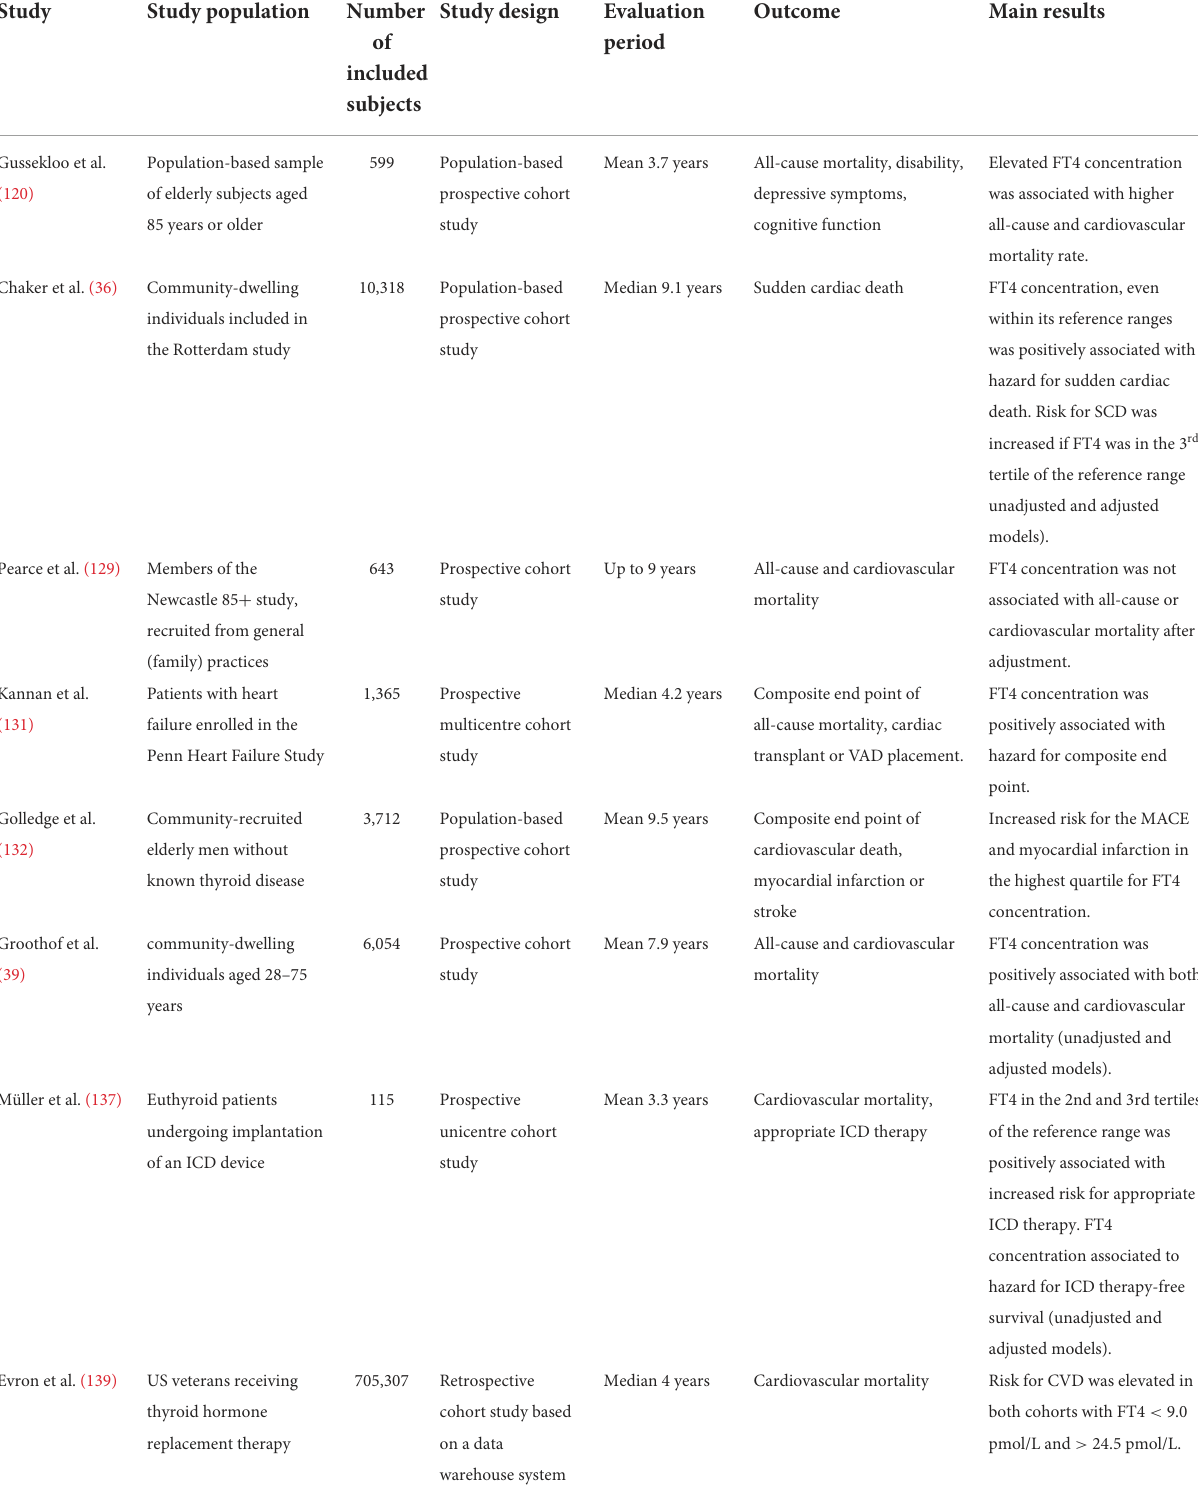
TABLE 3 Association between FT4 concentration and major cardiovascular outcome